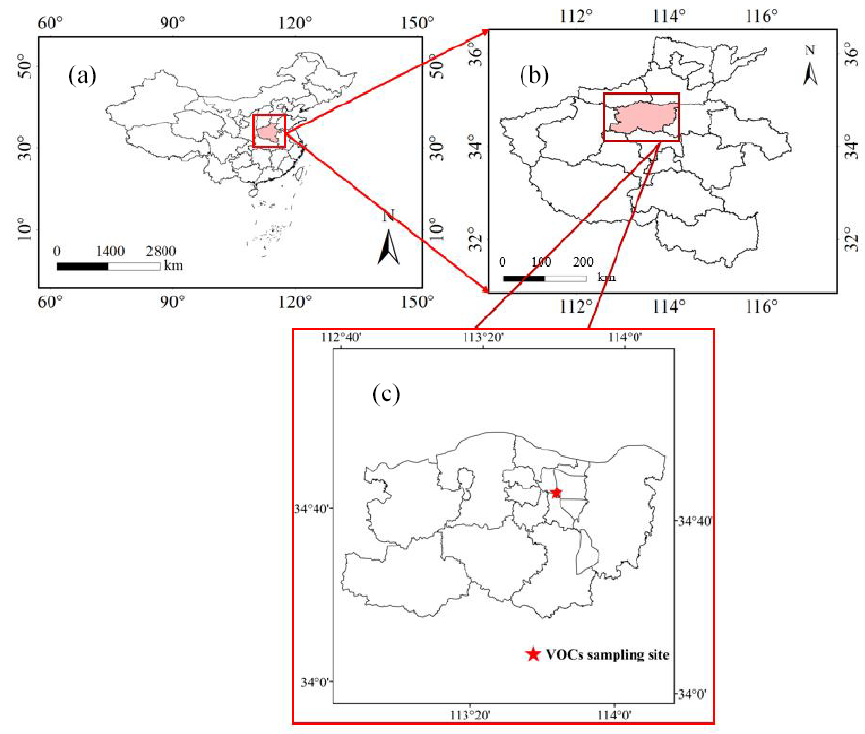
Figure 1. Locations of the sampling stations. (a) China, (b) Henan, and (c)